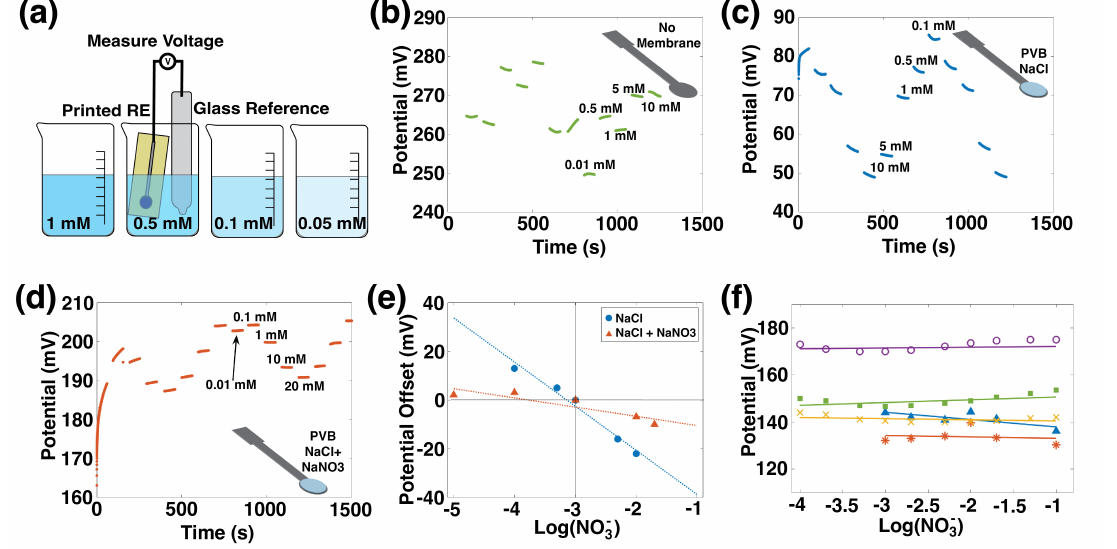
Figure 3. ( a ) Measuring a printed reference electrode against a commercial reference electrode in NaNO 3 solutions of varying concentrations. Potential over time in changing concentrations of nitrate of a printed Ag/AgCl reference electrode with ( b ) no added membrane, ( c ) PVB membrane with NaCl added, and ( d ) PVB membrane with NaCl and NaNO 3 added. Measurements in ( b – d ) were done against a commercial Ag/AgCl reference electrode. ( e ) Sensitivity of printed reference electrodes with NaCl in PVB membrane (blue), and NaNO 3 and NaCl in PVB membrane (red). The absolute value of the voltage measured at 1 mM NaNO 3 has been set to 0 mV to facilitate comparison of slopes. ( f ) Sensitivity of five printed reference electrodes to NO 3 is 2.96 ± 1.9